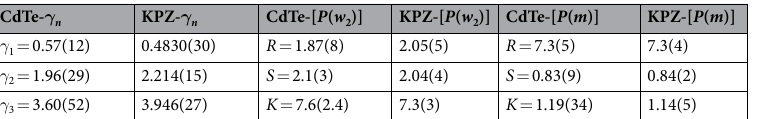
Table 2. (Left) Asymptotic γ n exponents from generalized FV scaling relation 3. The KPZ values were calculated using the estimates of α and β in 53, 54 . Cumulant ratios R , S and K for stationary width (middle) and maximal height (right) distributions calculated with WBCs. All KPZ values for the cumulants were extracted from ref.